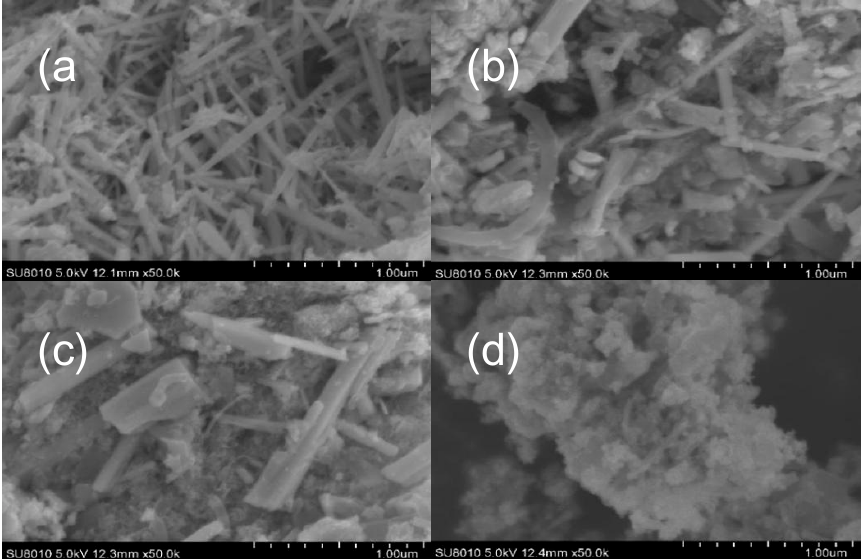
Figure 2. Scanning electron microscope (SEM) images of the Mo–Bi BMC nanoparticles synthesized at different hydrothermal temperatures: ( a ) 185 °C, ( b ) 200 °C, ( c ) 215 °C, and ( d ) 230 °C.